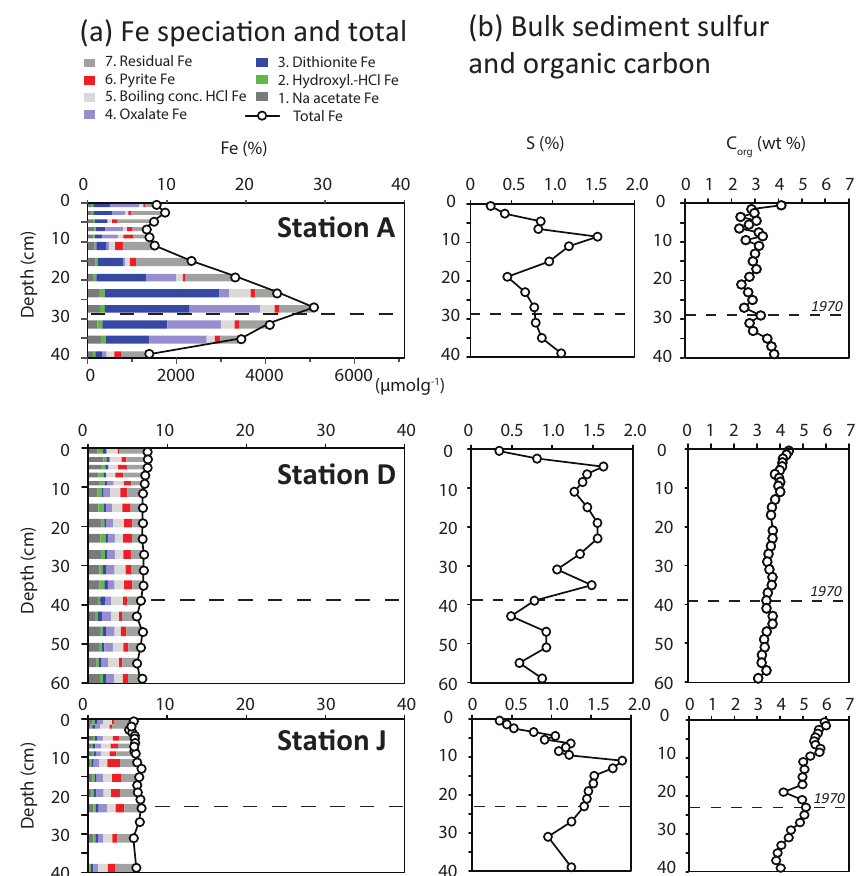
Figure 5. (a) Down-core operational Fe speciation and total sedimentary Fe content for Stations A, D, and J. Thickness of bars corresponds to thickness of sampled interval (i.e., 1 or 2cm). Note that not all depth intervals were sampled. (b) Bulk chemical profiles from the same cores. The depth interval corresponding to 1970 is estimated from the peak in concentrations of total lead (Pb tot ) (see Fig.